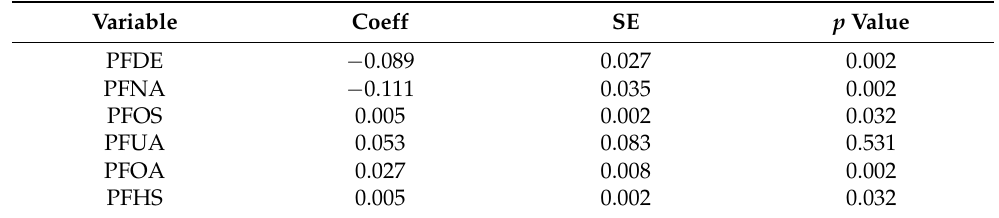
Table 6. Association between AL and PFASs of interest, behavioral health (physical activity, smoking, and alcohol consumption) age, gender, ethnicity (adjusted models *).